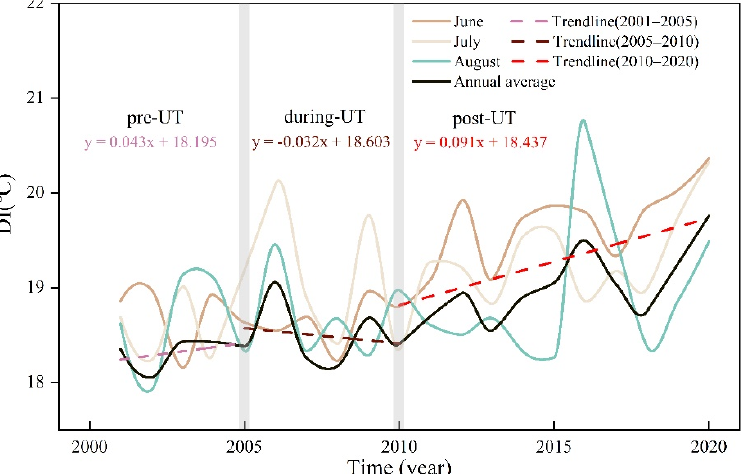
Figure 3. Annual and monthly changes of DI at different time scales in Chenggong District. Note: The red dotted line in the figure is the change trend of annual average DI, divided into two sections, before the completion of the university town (2001–2010) and after the completion of the university town (2010–2020).